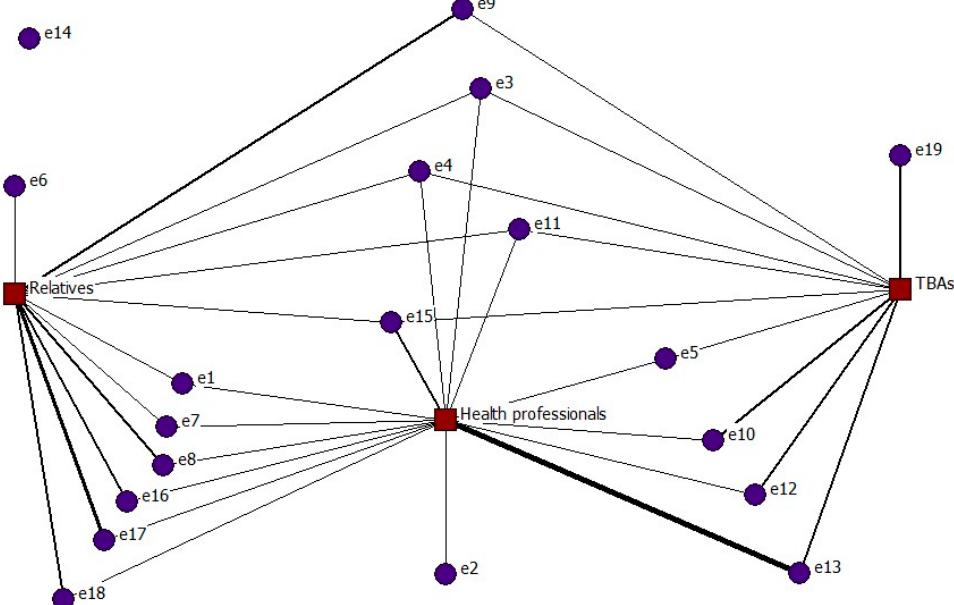
Figure 2. Two-mode network of home birth care provided by health professionals, TBAs or relatives.